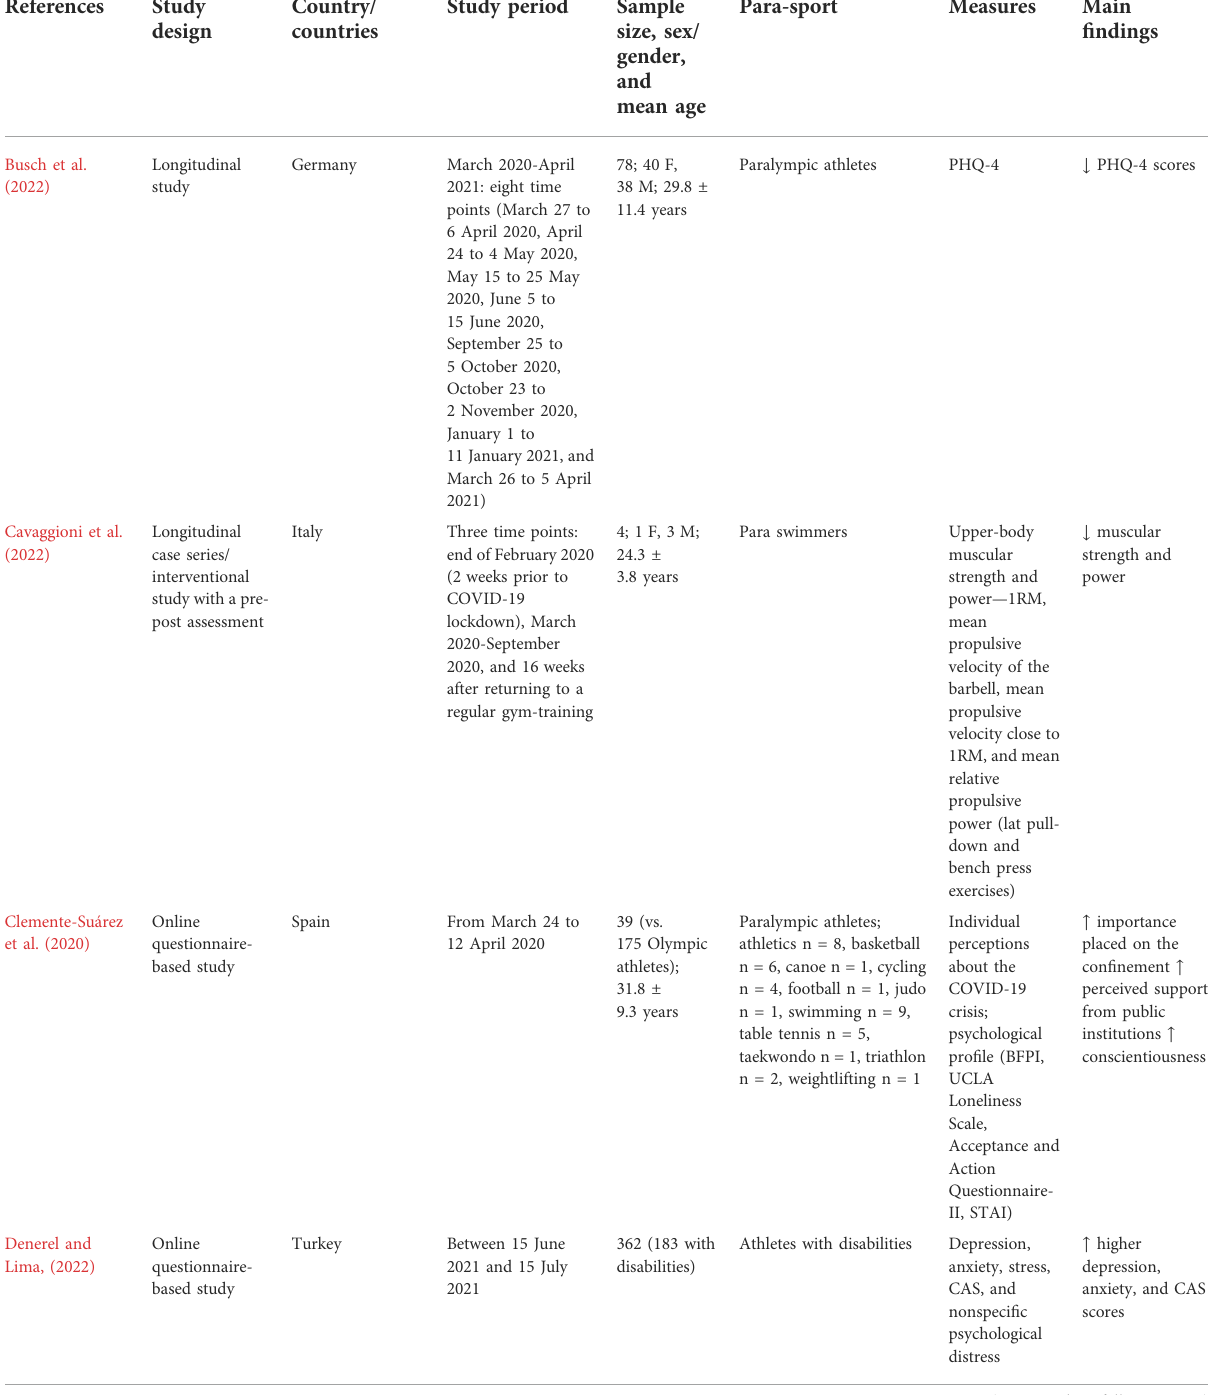
TABLE 2 Main features of included studies. Abbreviations: BFPI, Big Five Personality Inventory; CAS, coronavirus anxiety; CMJ, countermovement jump; FFQ, Food Frequency Questionnaire; MAT, modi fi ed agility t -test; NA, not available; 1RM, one repetition maximum; PHQ-4, Patient